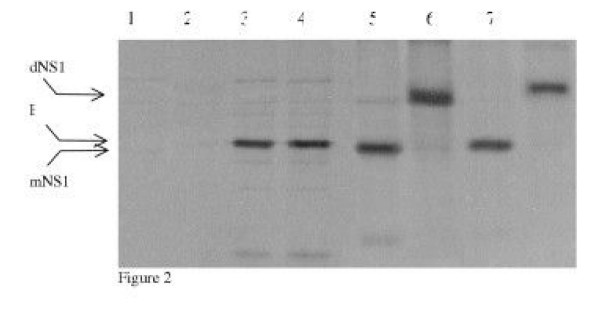
Study of mouse sera in RIPA with the TBE virus infected and radioactive labeled SPEV cell extracts. Lanes 1 and 2 – serum from intact mice; lanes 3 and 4 – anti-E protein Mab; lanes 5 and 6 – mouse anti-NS1 serum [9]; lanes 7 and 8 – pooled sera from mice vaccinated with W-NS1 and pMV45 which survived after the challenge with the TBE virus. Odd lanes: samples were boiled before SDS electrophoresis; even lanes: samples were not boiled before electrophoresis. The position of E protein, monomers (mNS1) and dimers (dNS1) of the NS1 protein are marked with arrows.